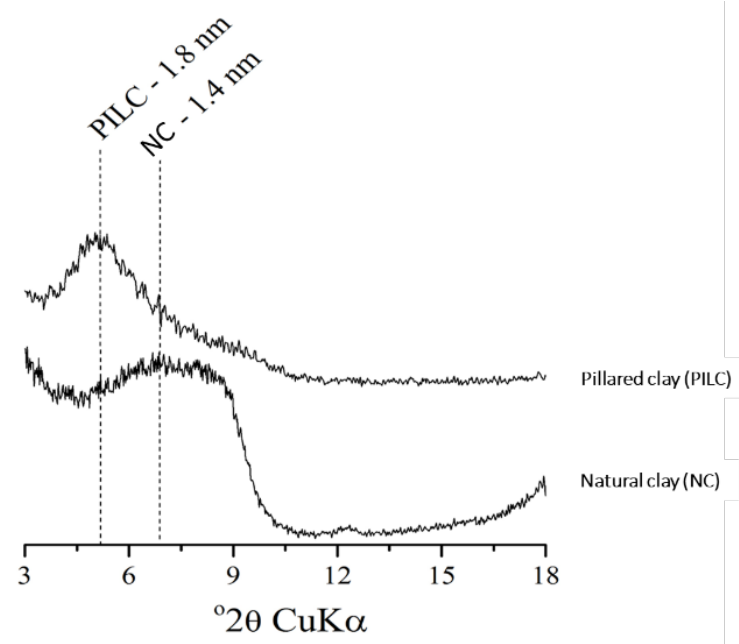
Figure 1. X-ray di ff ractograms of natural clay and pillared clay after calcination at 350 ◦ Figure 1. X-ray diffractograms of natural clay and pillared clay after calcination at 350 °C.